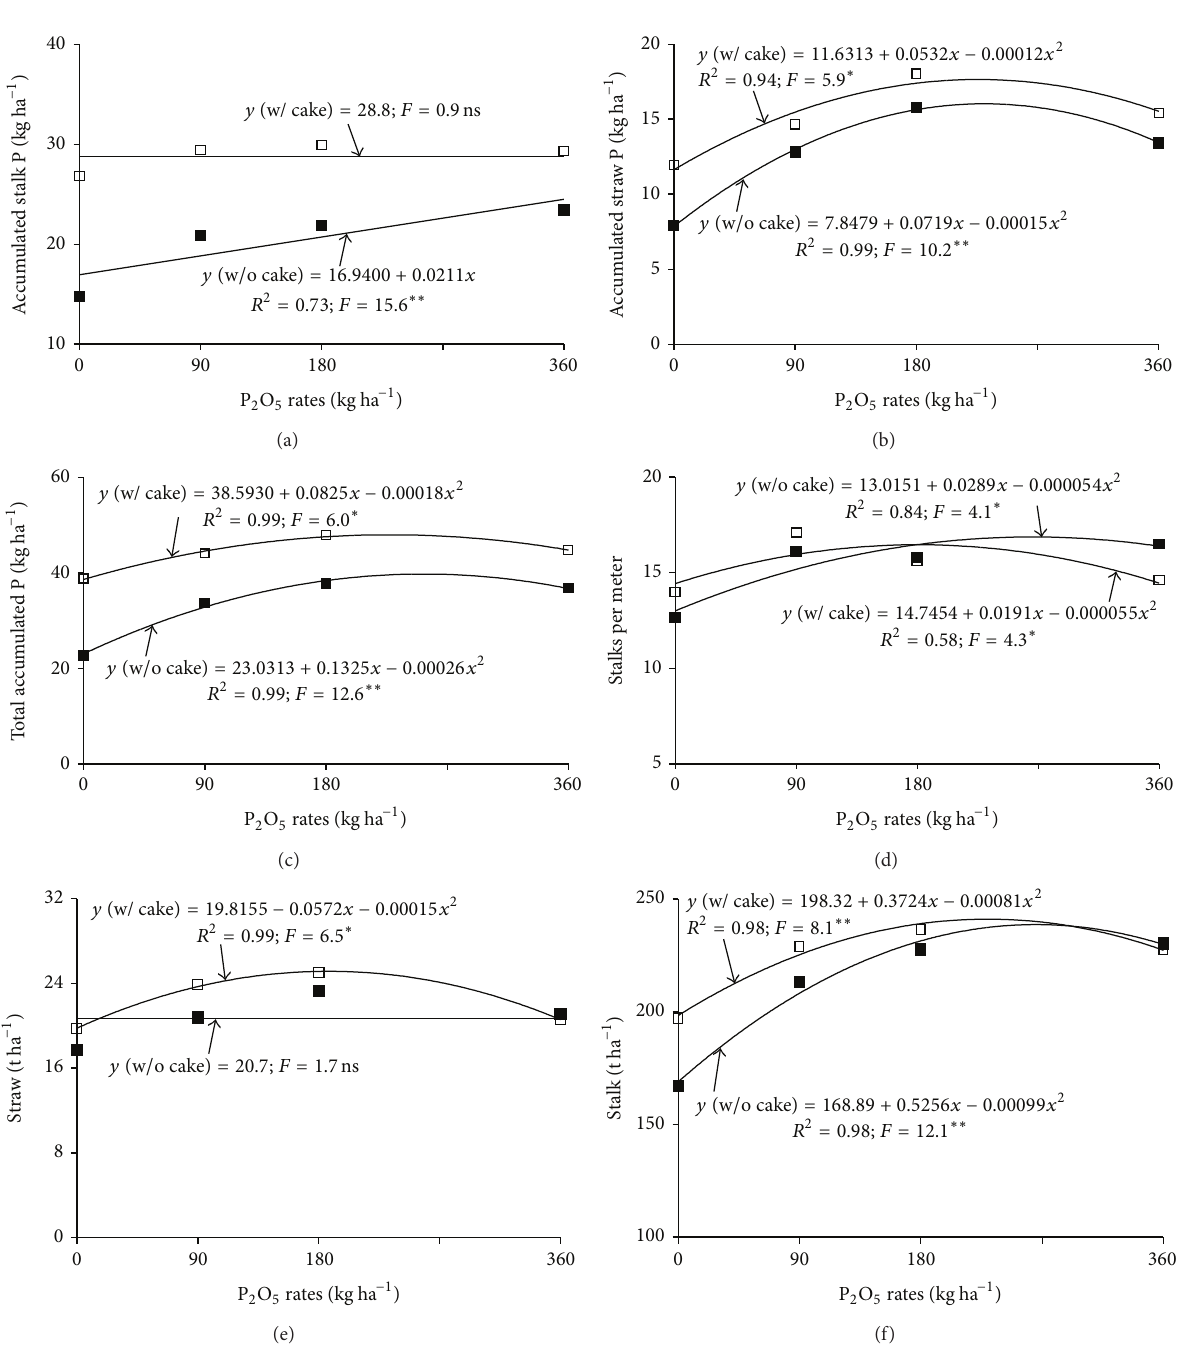
higher as P is essential for the synthesis of ATP and numerous other phosphorylated compounds [1]. This causes improved root development, tillering, and production [2]. The capacity for triple superphosphate fertilization to increase available soil P, plant absorption, and sugarcane productivity was also shown in Dystrophic Red-Yellow Oxisol (Typic Acrustox) [21] and Dystrophic Red-Yellow Ultisol [19]. Combining